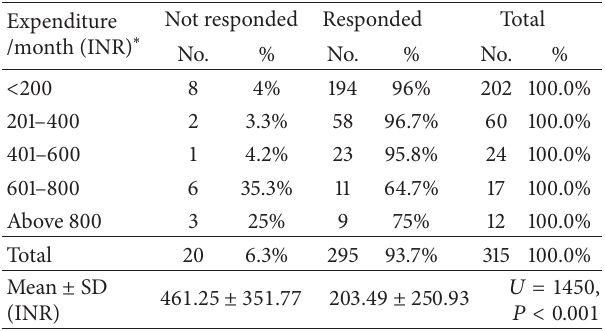
Table 7: Distribution of average total expenditure for treatment of epilepsy according to status of response ( 𝑛 = 315 ).